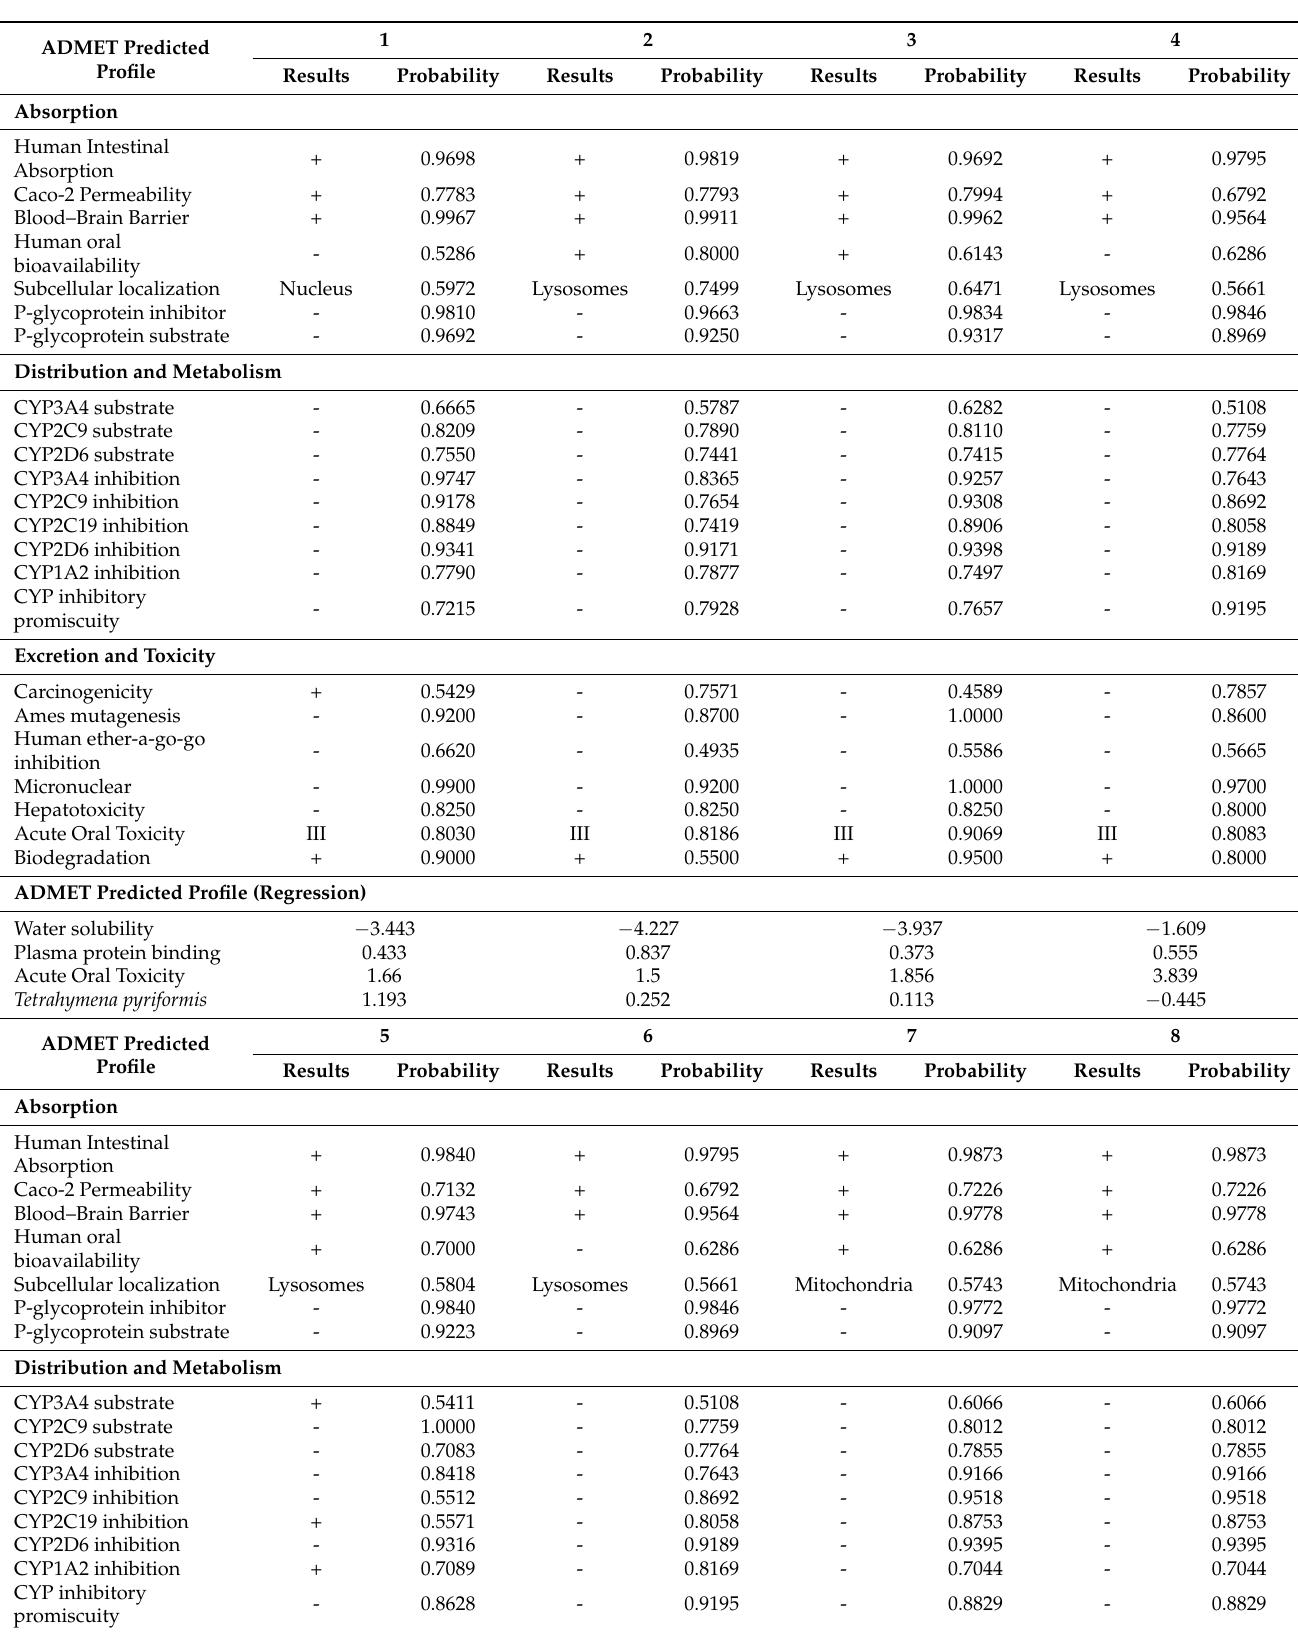
Table 7. ADMET properties of the identified compounds from caraway essential oil. Compounds 1 – 12 are the same as those listed in Table